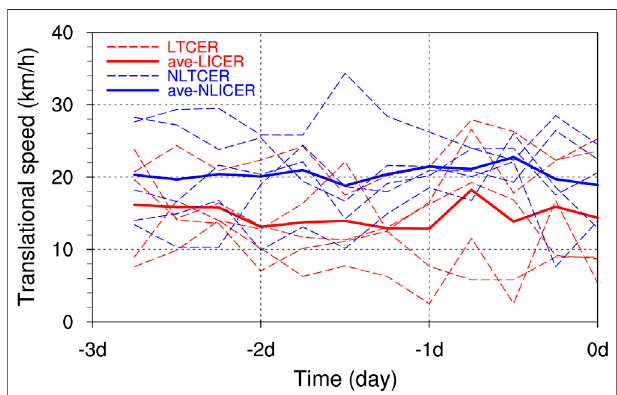
FIGURE 8 | Translational speed (units: km h − 1 ) of each selected ERLTC case (red dashed lines) and NERLTC case (blue dashed lines) and their composite average (red solid line for ERLTC cases and blue solid lines for NERLTC cases) calculated by their latitudinal and longitudinal position records at 6-h